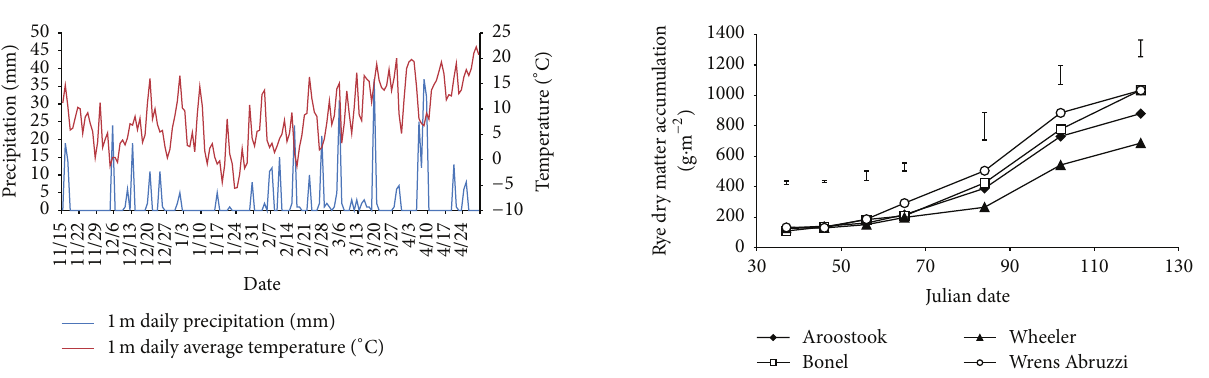
Figure 8: Average daily precipitation and temperature values recordedattheCherryResearchStationnearGoldsboro,NC,during year 1.